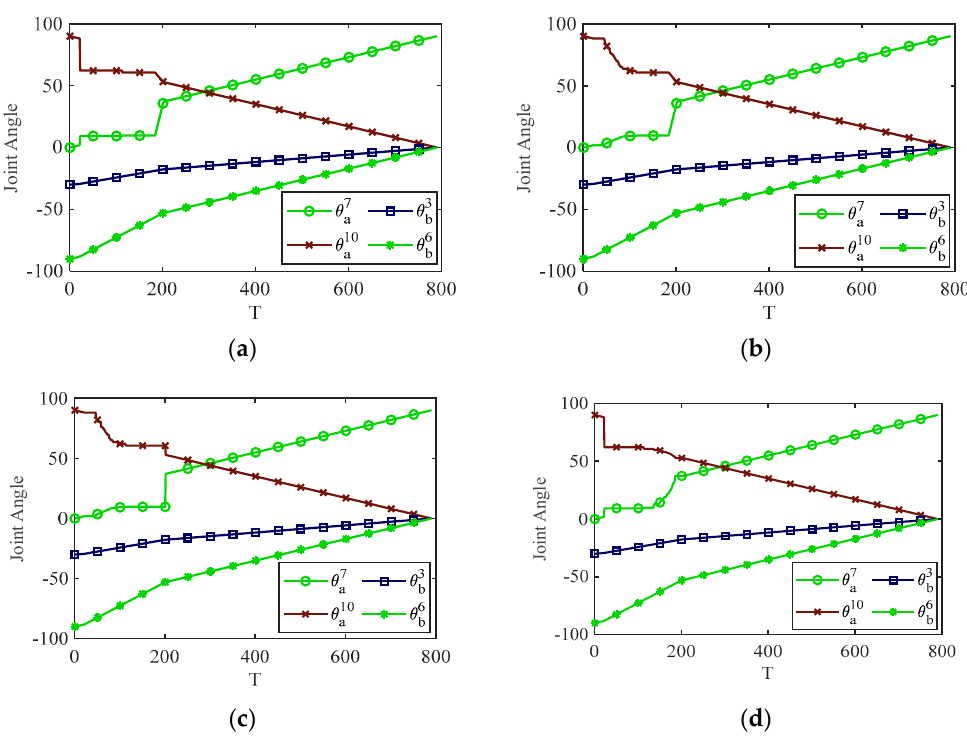
Figure 24. Paths of all motion joints of the SMSRS under four collision-free paths: ( a ) path 1, ( b ) path 2, ( c ) path 3 and ( d ) path 4.